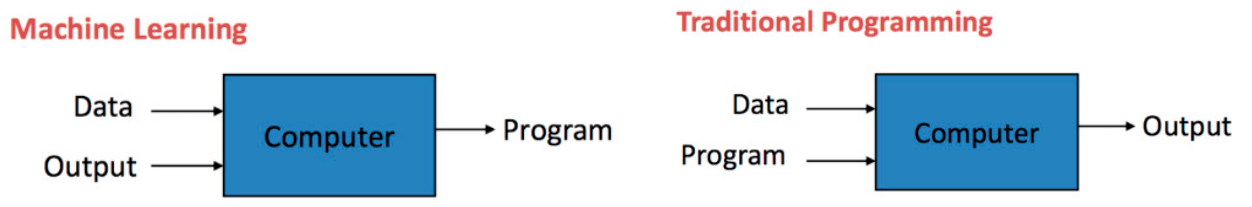
Figure 6. Traditional programming versus machine learning.